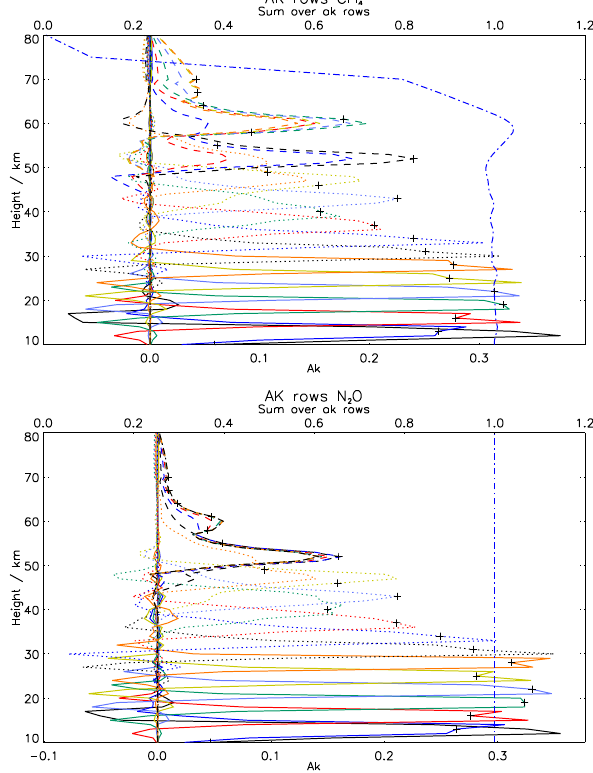
Figure 13. As Fig. 10, but for the measurement in orbit 10324 at 1 46.0 ◦ N, 144.5 ◦ W on 20 February 2004, 07:48:31UTC (derived from full-resolution spectra, version 1 Figure 12. As Fig. 9, but for profiles from full-resolution spectra (versions V5H_CH4_21 and V5H_N2O_21).